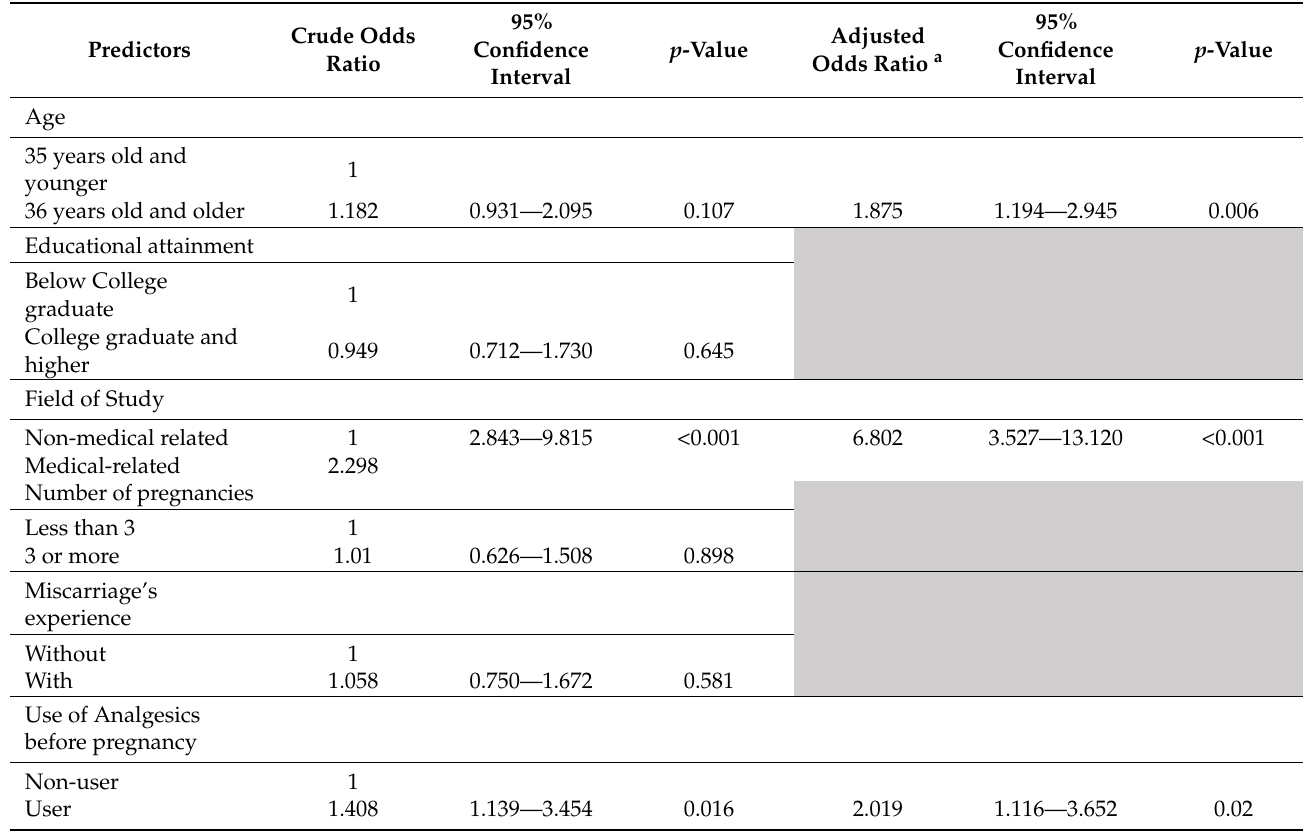
Table 5. Crude and adjusted odds ratio of the association between level of knowledge regarding analgesic use during pregnancy and various medico-socio-demographic